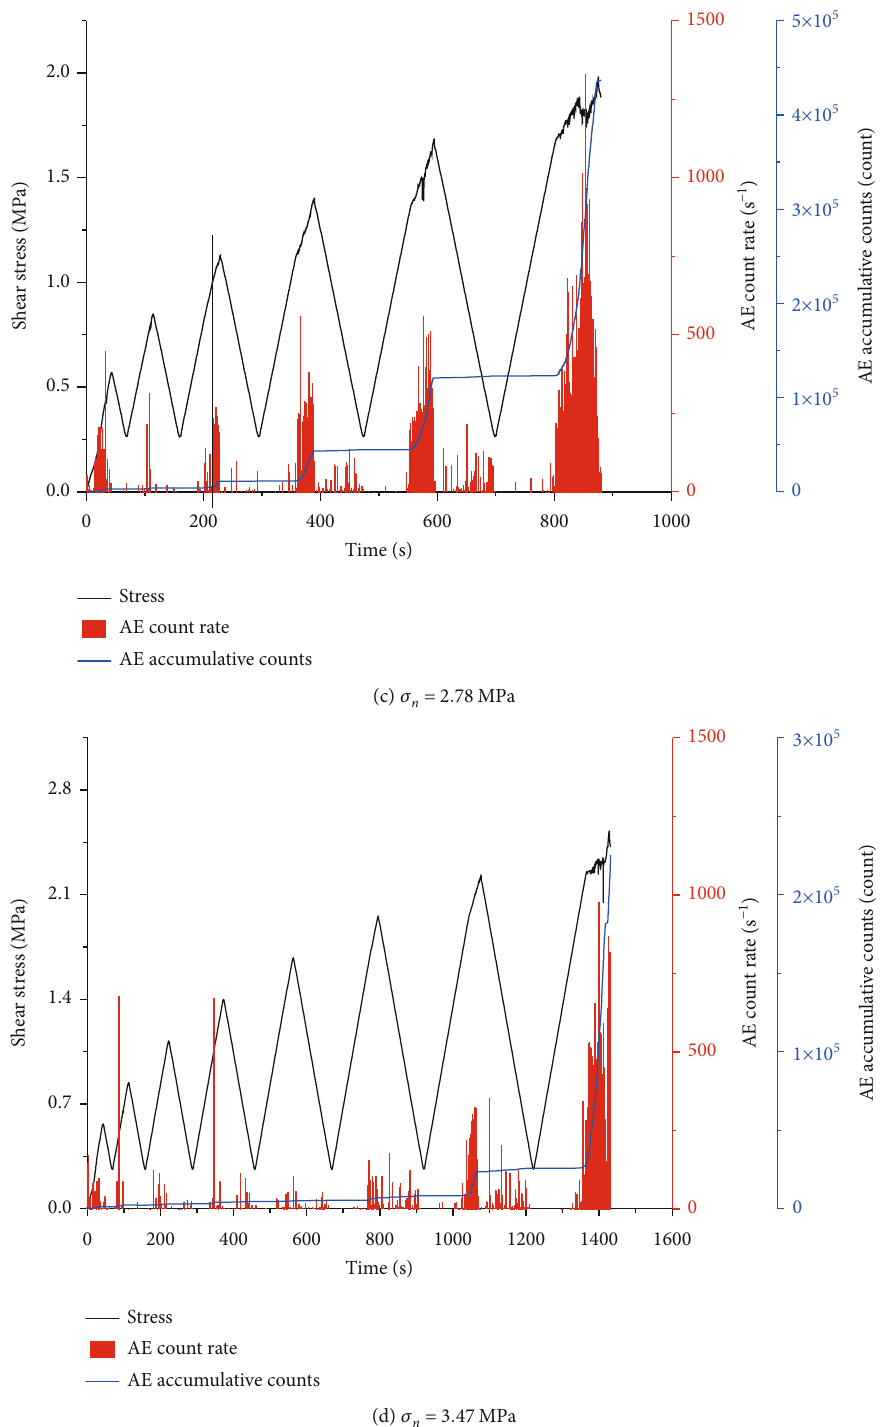
Figure 7: The relationship between the shear stress, AE count rate, AE accumulative counts, and the test time for skarn joints under normal stress of 1.39, 2.08, 2.78, and 3.47MPa,